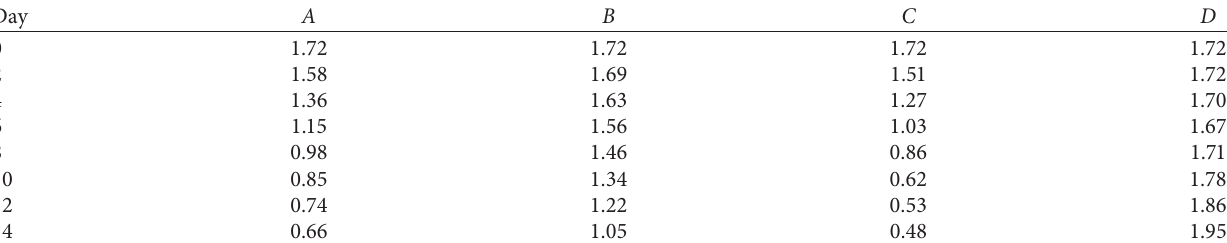
Figure 4: Changes of total nitrogen content in wastewater treated by microbes and plants. Table 6: Microbial-plant combined treatment wastewater total phosphorus content change data table.